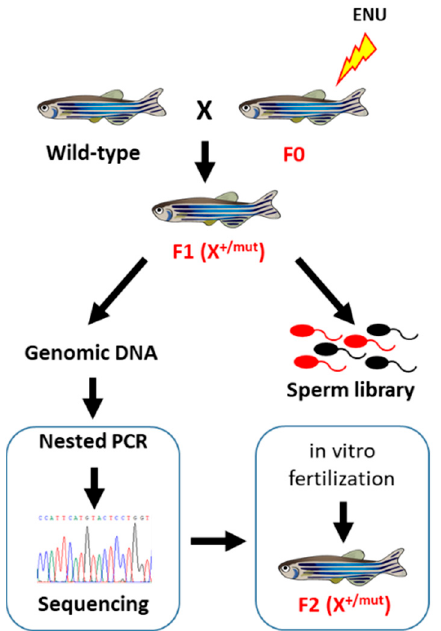
Figure 2. Overview of the target-selected mutagenesis in zebrafish. Male zebrafish treated with N-ethyl-N-nitrosourea (ENU) are mated to wild-type females. The resulting F1 male progeny are grown to breeding age and sacrificed to create a mutagenesis library consisting of genomic DNA, used to screen for F1 males harboring mutations in genes of interest (left) and cryopreserved sperm from each individual fish, for recovering the mutant lines using in vitro fertilization (right). This procedure permits the recovery of 50% heterozygous mutant zebrafish in the F2 generation.